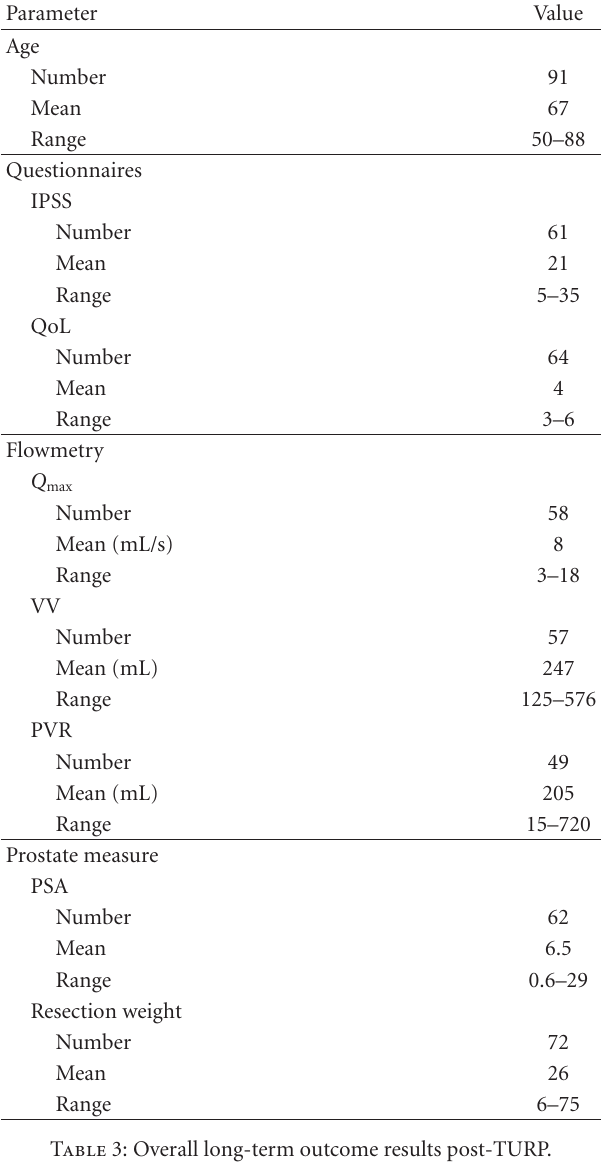
Table 2: Baseline characteristics for men undergoing TURP.